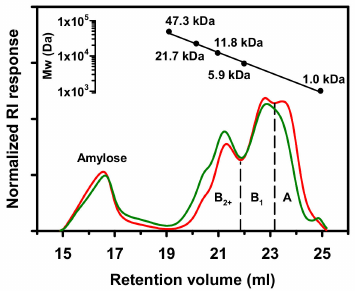
Figure 1. Chromatograms of isoamylase-debranched tapioca ( — ) and potato ( — )